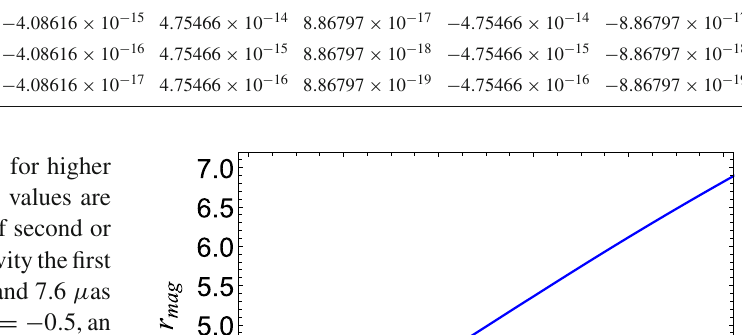
ondary images, respectively. (b) We have used M M87* = 6 . 5 × 10 9 m, D OL = 16 . 8 × 10 6 pc. (c) Angular positions of first order relativis- tic images in GR and Horndeski Gravity are, respectively, θ 1 p , GR ≈ − θ General relativity